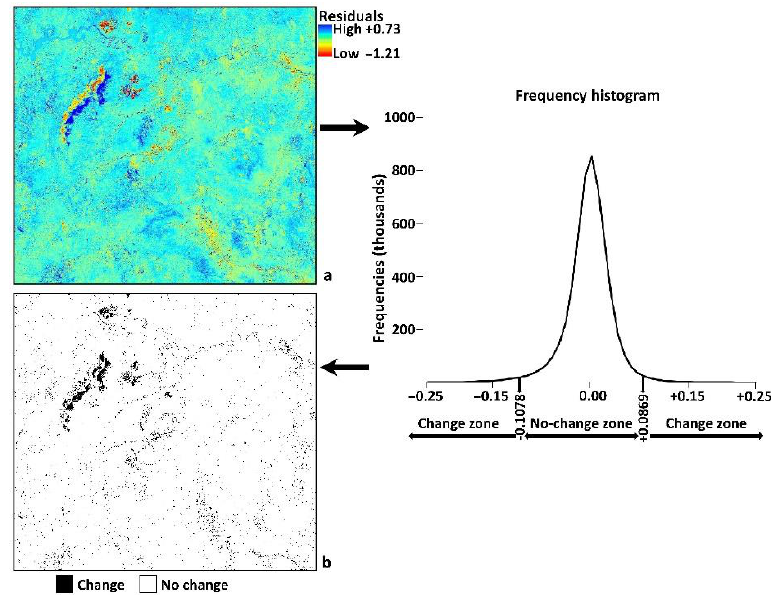
Figure 8. Change detection process by LR of the first PCs. ( a ) Image of continuous change (residual), ( b ) Thematic map of change obtained by thresholding the residuals by the secant method.